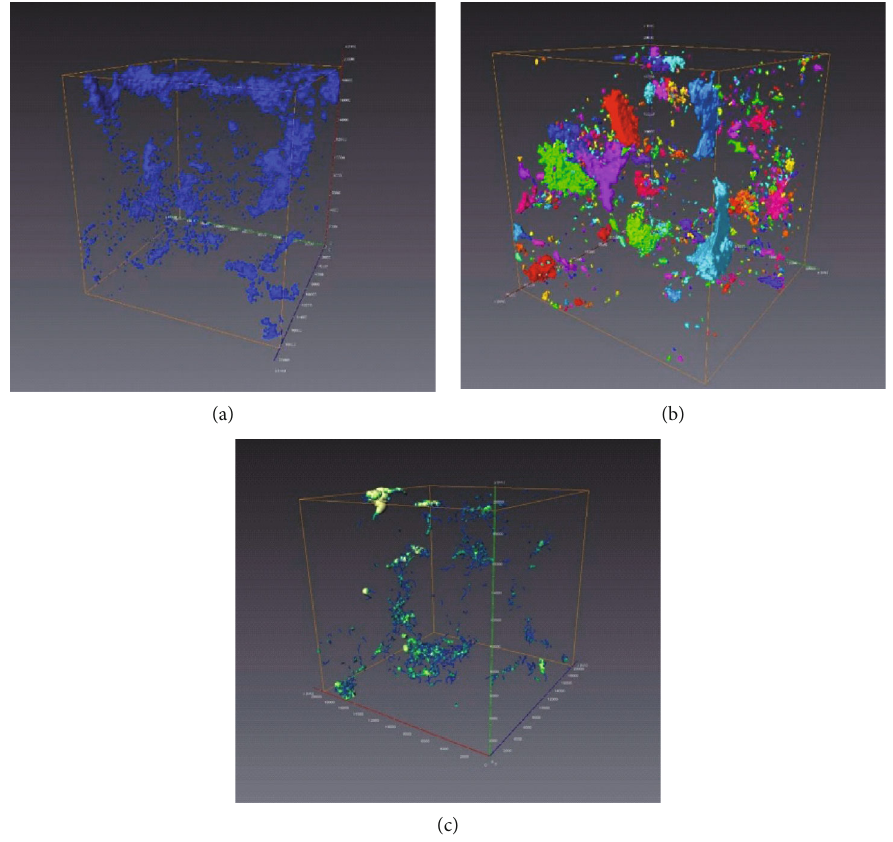
Figure 14: Organic pore characteristics of the shale based on the nano-CT. TOC is 1.6%. (a) The blue part is organic matter. (b) Interconnected pores in the organic matter. (c) Throat distribution in the organic matter.